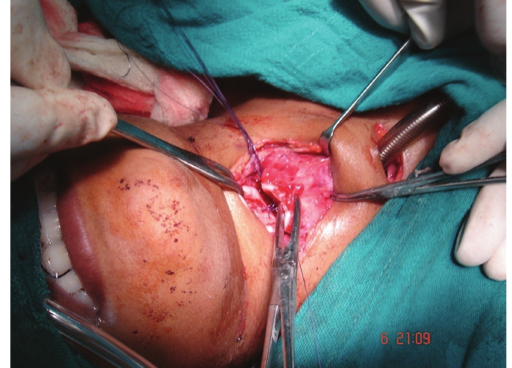
Figure 2: Clinical photograph showing end to end anastomosis with mobilization of trachea.